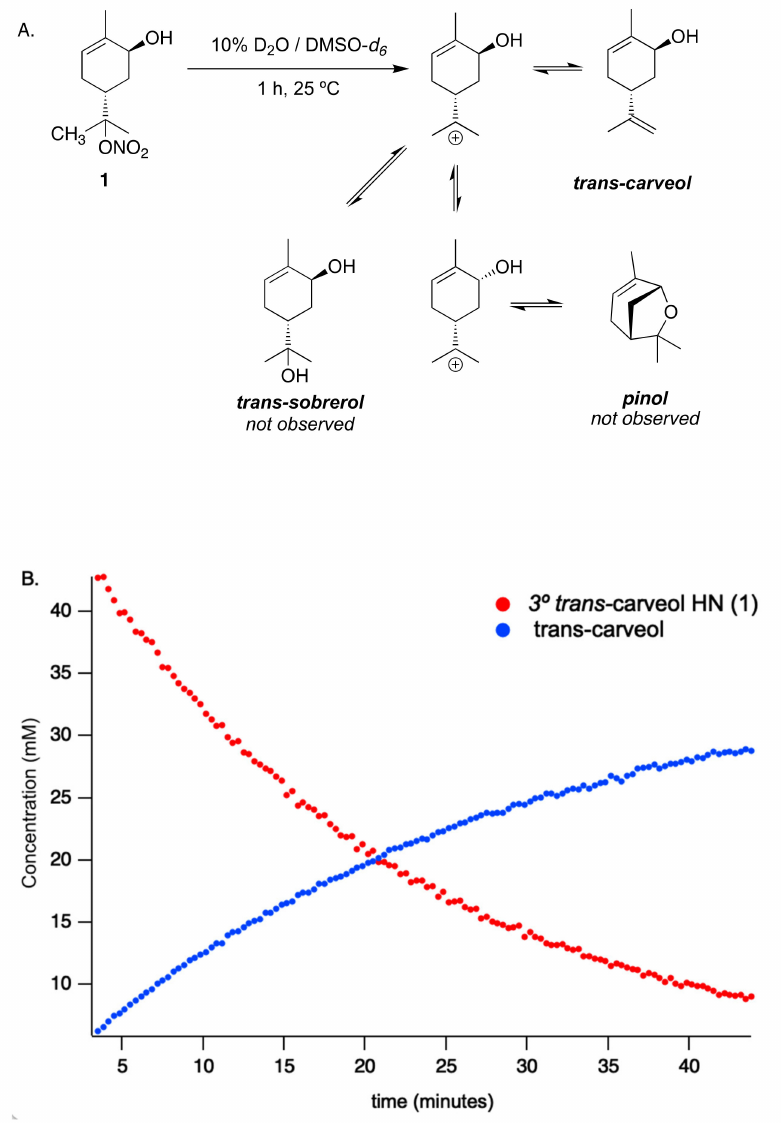
Figure 7. ( A ) Elimination and substitution reactions of trans -Carv ( 1 ); ( B ) time series for the conversion of trans -Carv ( 1 ) and the formation of trans -carveol in 10% D 2 O/DMSO- d 6 at 25 ◦